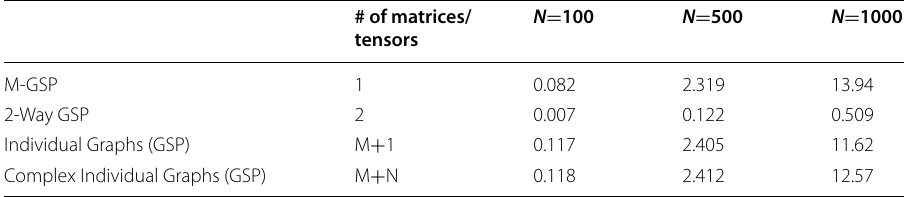
Table 6 Running time of graph construction